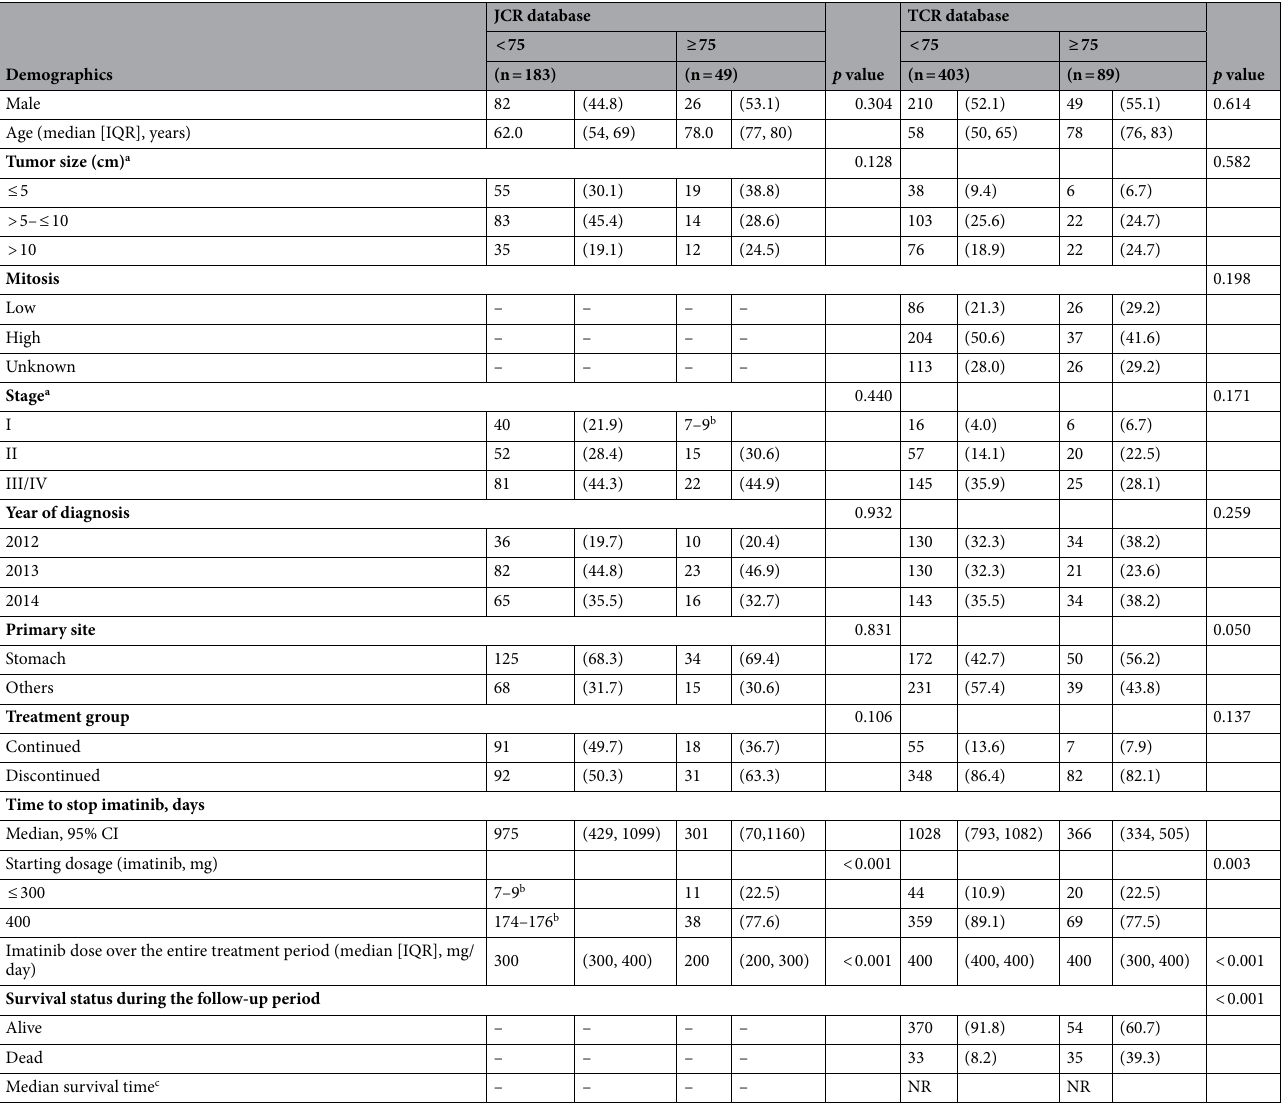
Table 2. Demographics of patients in the adjuvant setting after stratification by age. JCR Japanese Cancer Registry, TCR Taiwan Cancer Registry, CI Confidence interval, IQR Interquartile range, SD Standard